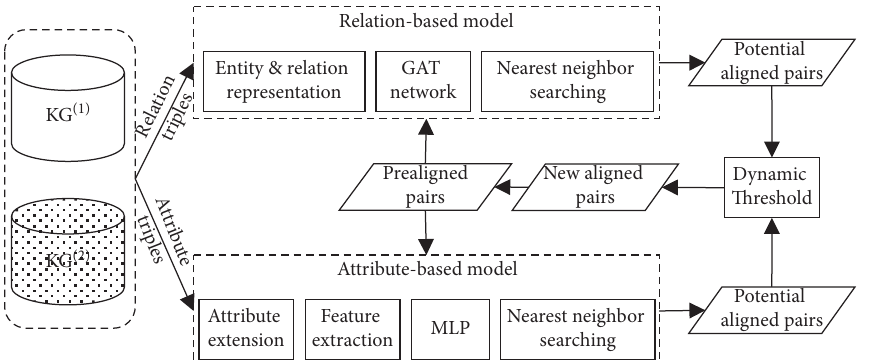
Figure 1: The overview of CAREA